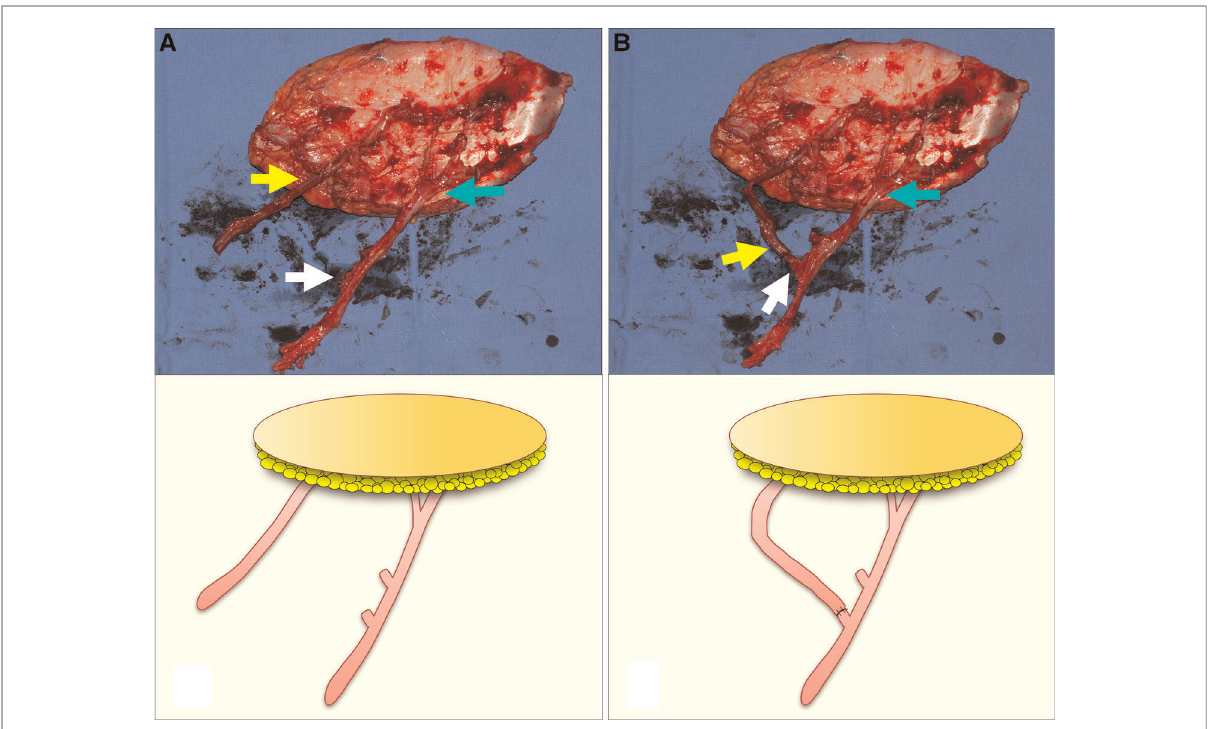
FIGURE 4 A simulation for demonstrating the turbocharging procedure in the wide ALTP fl ap supplied by perforators from both TB-LCFA and DB-LCFA (Each arrow indicates as follows: yellow indicates a perforator from TB-LCFA; green indicates DB-LCFA; white indicates side branches of DB-LCFA). ( A ) Before the procedure, the TB-LCFA of adequate length and the DB-LCFA with several potential candidate side branches were prepared. ( B ) The TB-LCFA was transposed to the selected side branches of the DB-LCFA, and the anastomosis between them was performed. ALTP, anterolateral thigh perforator; TB-LCFA, transverse branch of lateral circum fl ex femoral artery; DB-LCFA, descending branch of lateral circum fl ex femoral